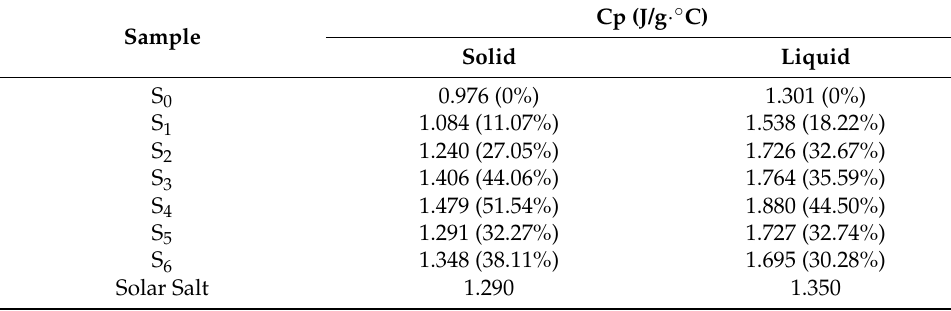
Figure 6. Specific heat capacity of ternary nitrate and modified nitrate: ( a ) solid phase, ( b ) liquid phase. Table 2. Specific heat capacity of ternary nitrate and modified nitrate.